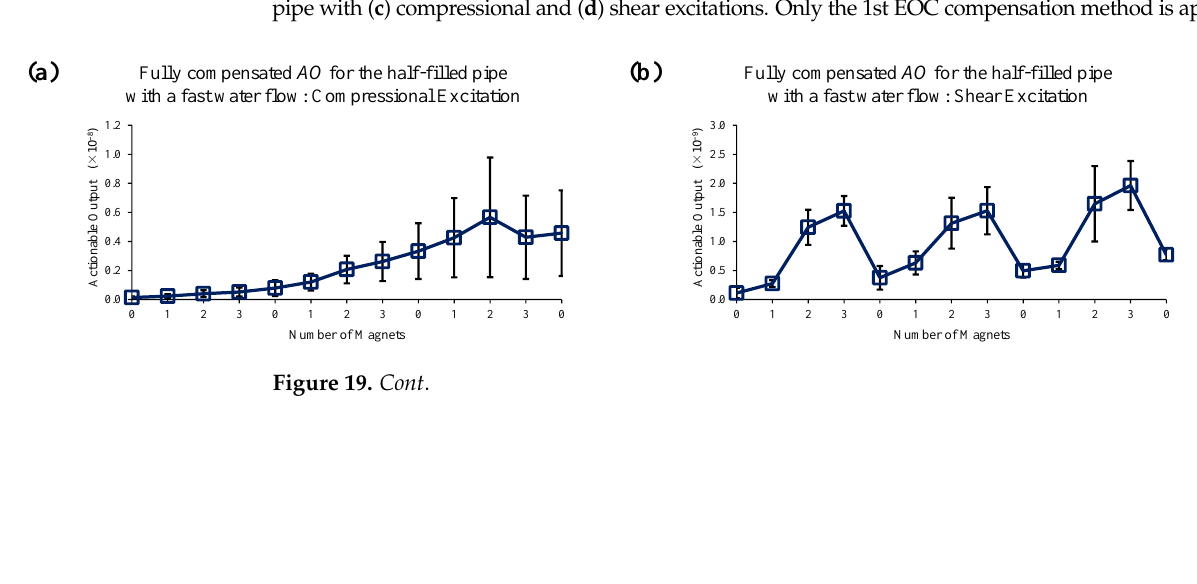
Figure 19. Changes in AO under fast water-flow conditions with the different number of magnet perturbations for the half-filled pipe with ( a ) compressional and ( b ) shear excitations; and the fully filled pipe with ( c ) compressional and ( d ) shear excitations. The full, two-level EOC compensation method is applied. 5. Summary and Conclusions In this manuscript, a multi-mode and broadband ultrasonic testing technique is de- scribed for non-destructive large-area inspection and monitoring of mechanical changes in pipes with static and dynamic liquid boundaries. The technique uses two single-ele- ment sensors either for compressional or shear ultrasonic excitation for transmission type measurement. The difference transmission signal to a prior baseline measurement is ana- lyzed to determine AO , a scalar quantity, which is a measure of mechanical changes. To assess the feasibility of the proposed technique in the case of pipes with liquid boundaries, a pipe system with adjustable tilt angle (half- and fully filled) and flow rate (stagnant, slow, fast) is constructed. The experimental results show that both the compressional and shear excitation modes provide a similar level of accuracy and sensitivity to the magnet perturbations once the UT method is improved with the two-level EOC compensation, which appear to be adequate for stagnant and slow flow cases under both partially and fully filled pipes. Under fast flow conditions, the performance of the technique degraded significantly, especially for the half-filled pipe case. Author Contributions: Formal analysis, investigation, writing — original draft, T.J.; conceptualiza- tion, writing-reviewing and editing, A.T.F. All authors have read and agreed to the published ver- sion of the manuscript. Funding: This research was funded by Cooperative Research and Development Agreement grant number LA05C10518-PTS-012. Institutional Review Board Statement: Not applicable. Informed Consent Statement: Not applicable. Data Availability Statement: Not applicable. This work was supported by Los Alamos National Laboratory. Conflicts of Interest: The authors declare no conflict of interest.